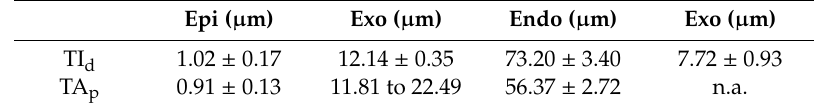
Table 2. Thickness of the cuticle layers of the tibial–tarsal joints of P. marginata (average values with standard deviations, n =